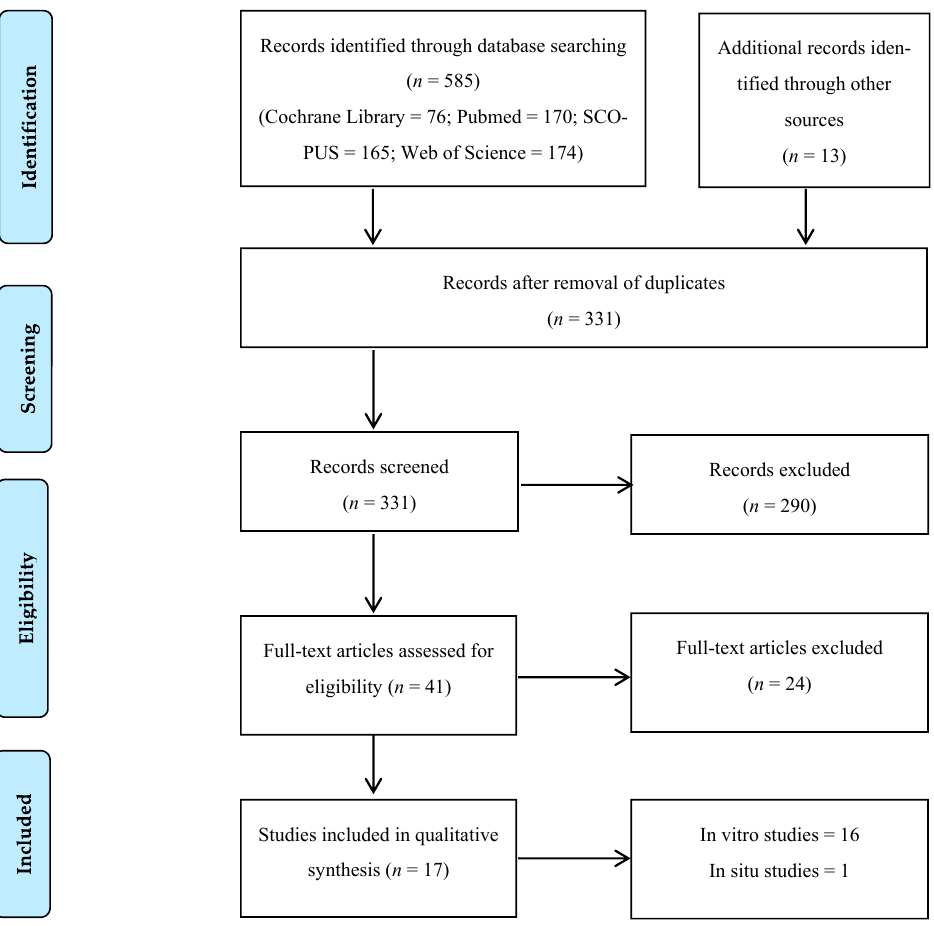
Figure 1. Flowchart of the data selection process.